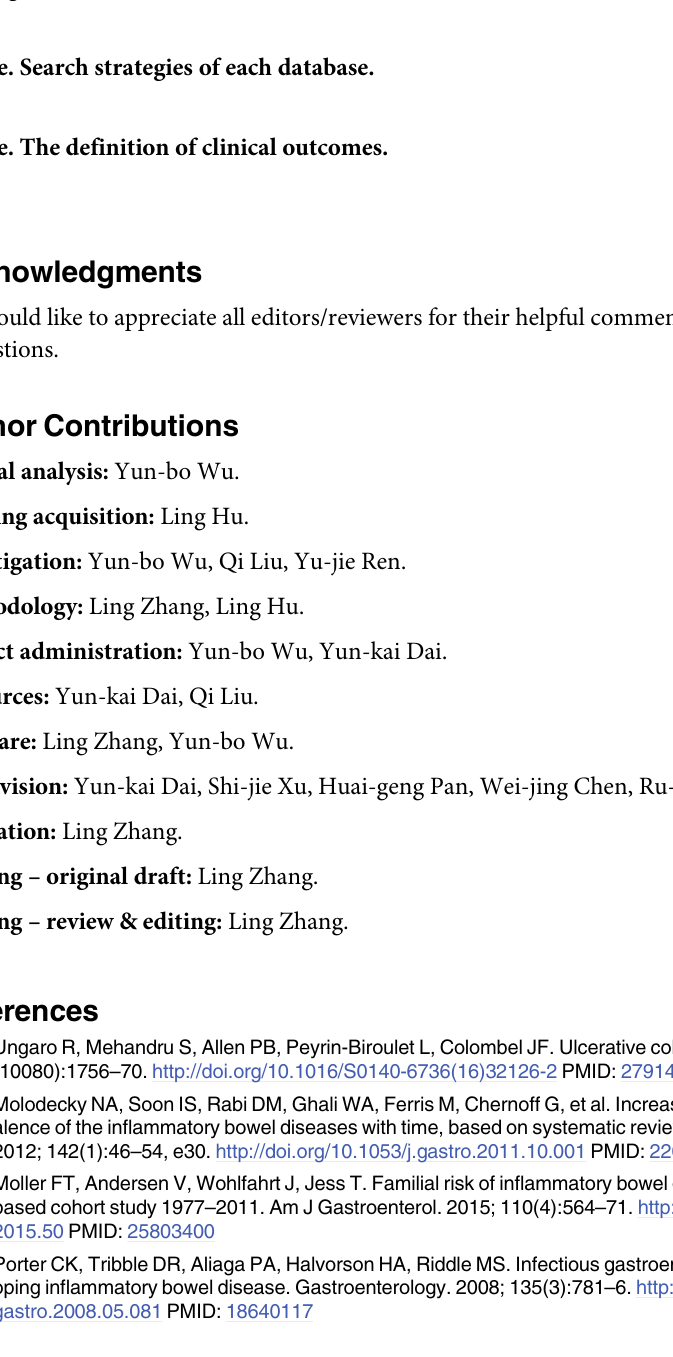
S1 Table. PRISM checklist. S2 Table. Composition of TCM decoction for included studies. S3 Table. Grade of recommendations assessment, development and evaluation quality grading